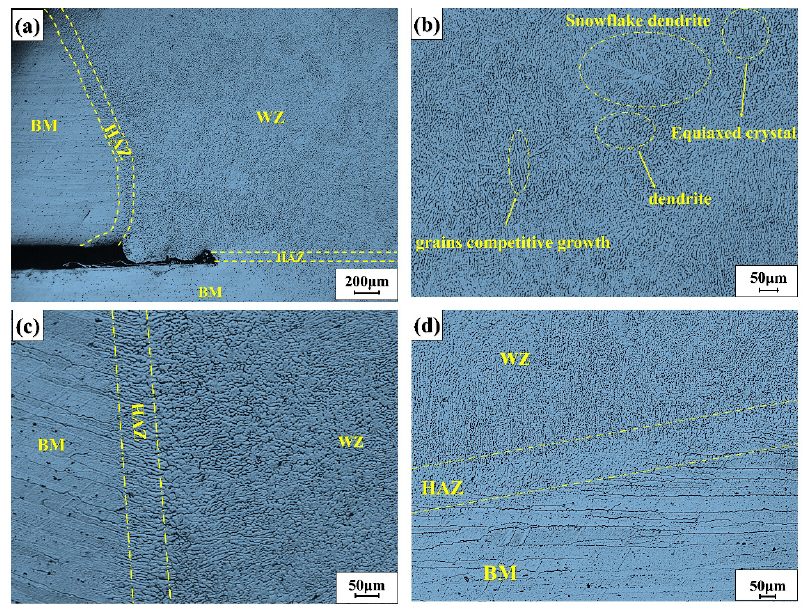
Figure 3. ( a ) The overall morphology of the welded part; ( b ) the microstructure of the weld zone; ( c , d ) are the microstructures of the joints in different directions.